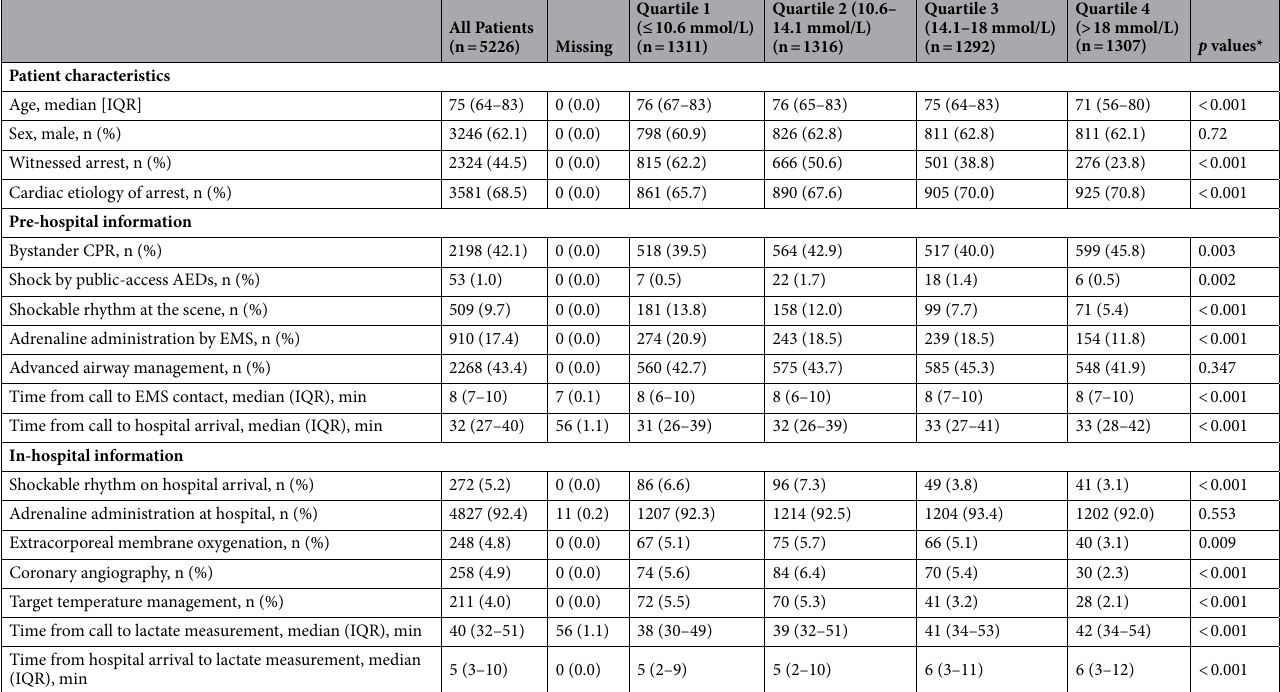
Table 1. Characteristics after OHCA patients by serum lactate level measured during cardiac arrest at hospital arrival. OHCA out-of-hospital cardiac arrest, ROSC return of spontaneous circulation, AED automated external defibrillator, CPR cardiopulmonary resuscitation, EMS emergency medical services, IQR Inter quartile range. *Comparisons between the four groups were evaluated with Kruskal–Wallis tests for continuous variables and χ 2 test for categorical variables.